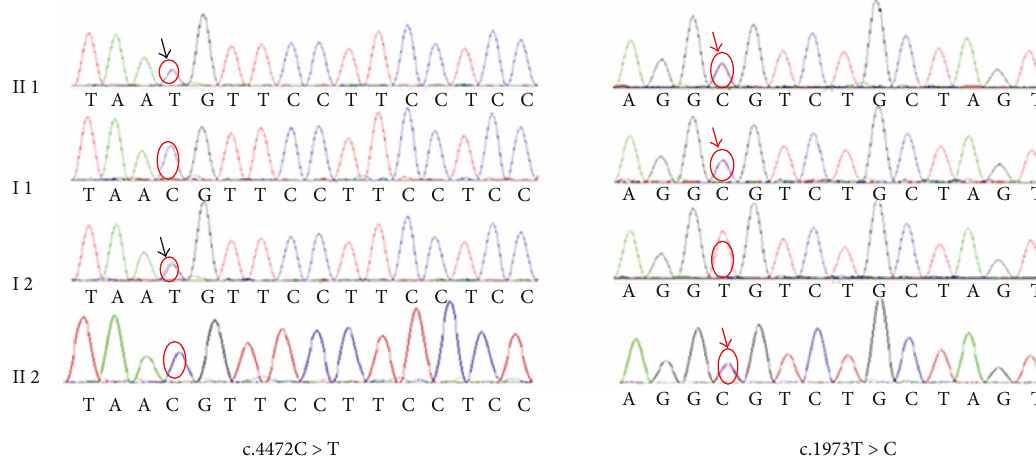
Figure 2: Electropherogram analysis of PTPRQ in Family 1. Electropherogram analysis showed that compound heterozygous mutations (c.4472C > T, black arrows and c.1973T > C, red arrows) cosegregate with the phenotype.